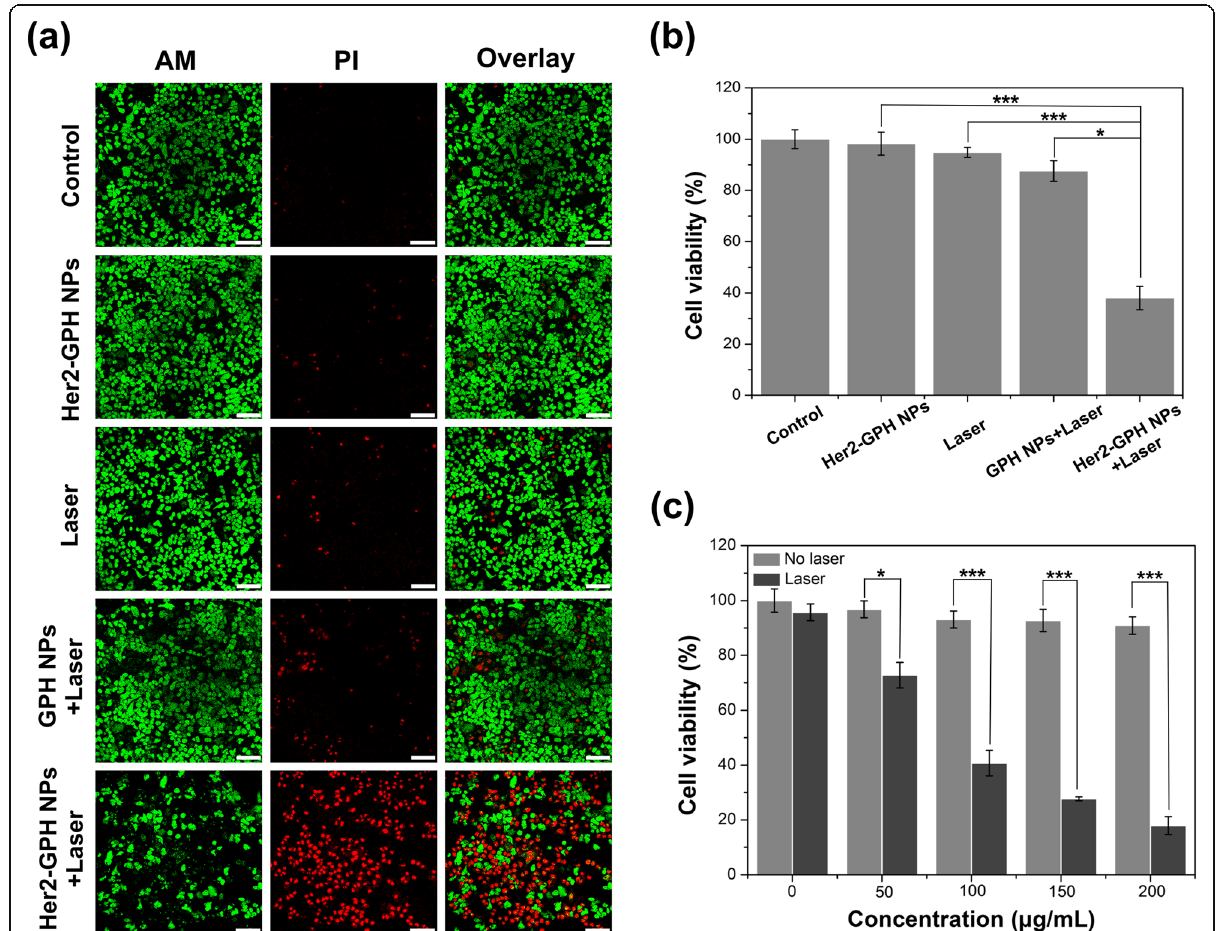
Fig. 11 In vitro targeted photothermal assay. a Confocal microscopic images of calcein-AM/PI-stained SKBR3 cells in in different treatments groups (Her2-GPH NPs group, laser group, GPH NPs + laser group, Her2-GPH NPs + laser group) (scale bar = 100 μ m). SKBR3 cells served as control. b Relative cell viabilities of SKBR3 cells in the five groups after treatment as shown in Fig. 11 a (data expressed as mean ± SD, * P < 0.05, *** P < 0.001, n = 4); c cell viabilities of SKBR3 cells incubated with Her2-GPH NPs at different concentrations (0, 50, 100, 150, 200 μ g/mL) with or without NIR laser irradiation (808 nm, 1 W/cm 2 , 10 min) (data expressed as mean ± SD, * P < 0.05, *** P < 0.001, n =